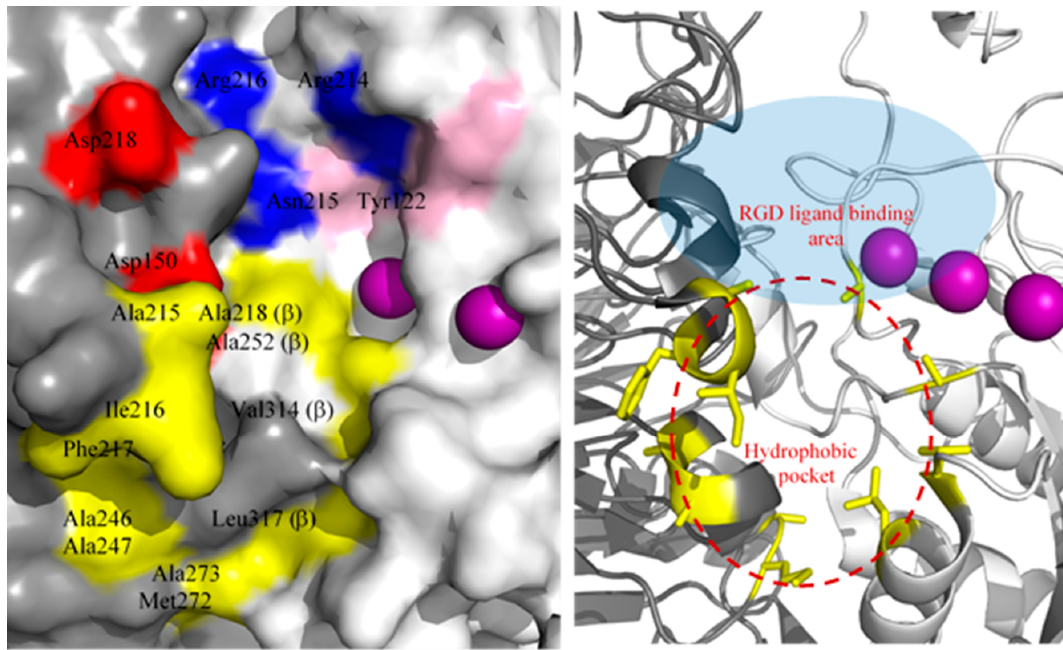
Figure 8. Left : The RGD ligand-binding area on the major surface of α v β 3 integrin (PDB ID 1L5G) with α -subunit in grey, β -subunit in light grey, Mn 2+ in purple. Asp150/Asp218 (red) in α v subunit form salt bridges with the arginine (R) guanidinium group of RGD ligand (i.e., cilengitide), whose aspartic acid (D) carboxy group contacts with Arg214 (blue), Asn215/Tyr122 (pink) in β 3 subunit. The Arg216 is also involved in the contact with the ligand. A cluster of hydrophobic amino acids highlighted in yellow on the surface of α - and β -subunit form a hydrophobic circle near the RGD binding area, including Ala215, Ile216, Phe217, Ala246, Ala247, Met272 and Ala273 from α -subunit; Ala218, Ala252, Val314 and Leu317 from β -subunit; Right : Closeup ribbon view of potential hydrophobic pocket (red dashed circle) at the major interface of α v (grey) and β 3 (light grey) subunits, which is nearby RGD ligand-binding area (light blue). Hydrophobic amino acids (names labeled same as above) with side chains shown are highlighted in yellow.